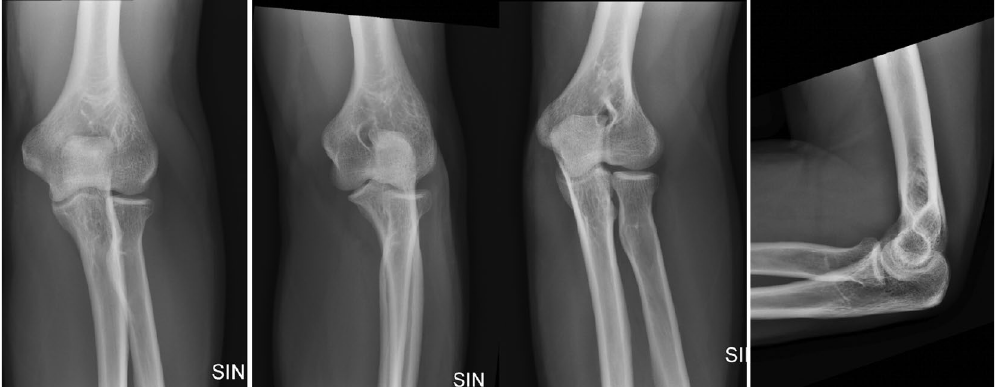
Figure 1. Example of normal adult radiographs including AP, external oblique, internal oblique and lateral projections used in this study.